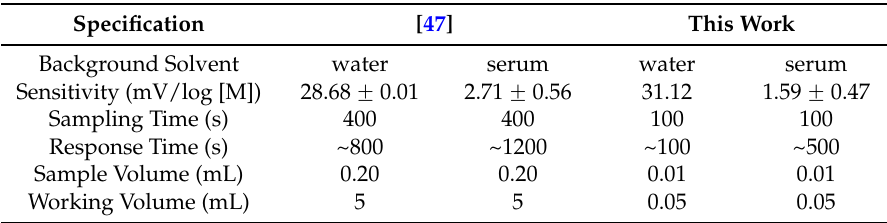
Table 3. Comparison between the proposed sensor and previous work.